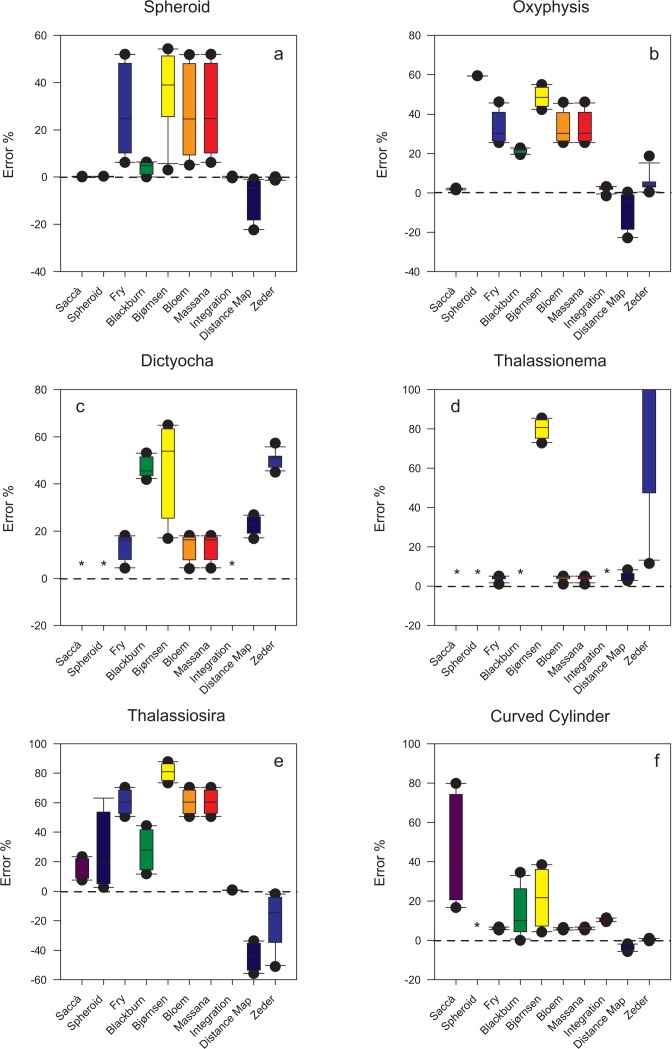
Box plots showing the errors caused by the new equation and the other tested methods in the estimation of the volume of the 3D shapes created with Cinema4D.The median, as well as the 10th, 25th, 75th, and 90th percentiles are shown. Whiskers indicate the 10th percentile and 90th percentile, respectively, while the extent of outlying points (solid circles) identifies the data range (standard method is used to calculate percentile values). The * symbol denotes that values are off scale.